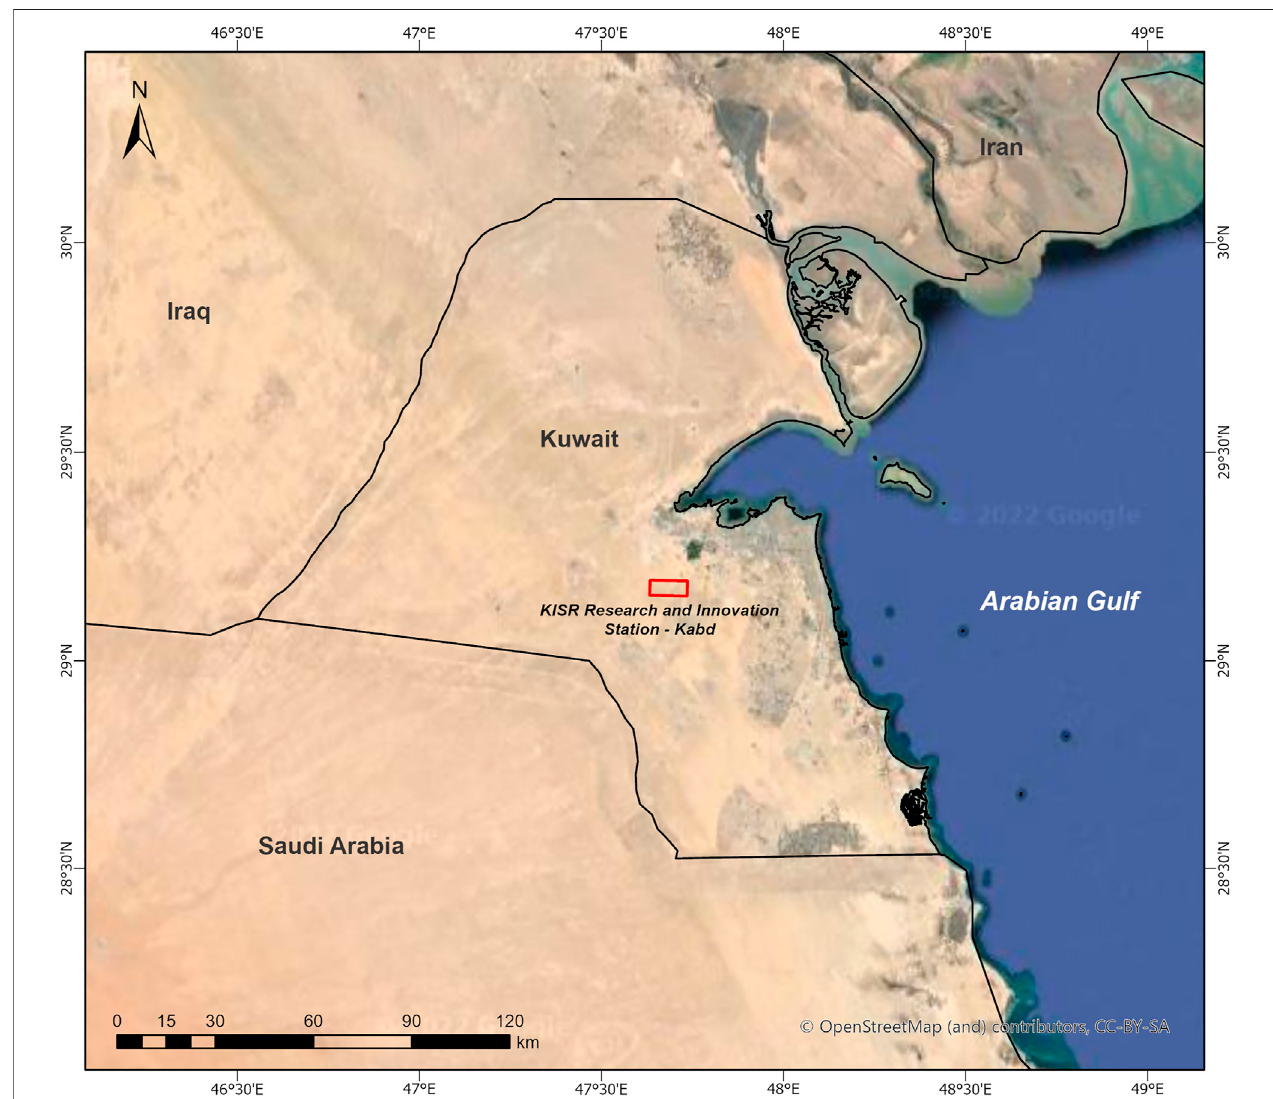
FIGURE 1 | Map of Kuwait showing the location of the KISR (Kuwait Institute for Scienti fi c Research) Research and Innovation Station — Kabd, Al-Jahra Governorate, Kuwait.